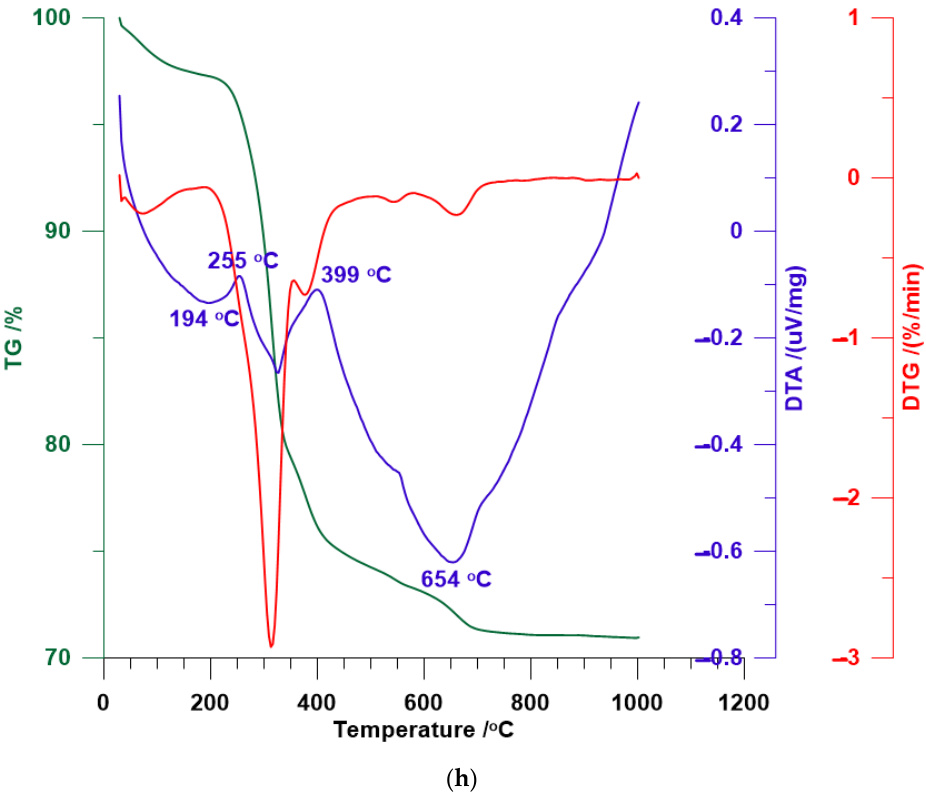
Figure 4. Thermal analysis thermogravimetric analysis / di ff erential thermal analysis (TG / DTA) of: ( a ) BENT, ( b ) HD-B, ( c ) HD-TX-2, ( d ) HD-TX-48, ( e ) HD-TX-120, ( f ) TX-2, ( g ) TX-48, and ( h ) TX-120.